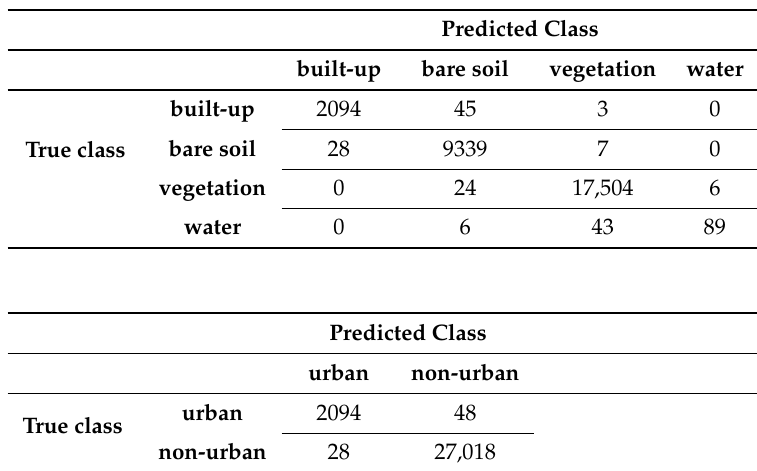
Table 3. Confusion matrices for the classification process of Landsat images in Valledupar. The top table corresponds to the initial classification process of pixels into four categories, and the bottom table corresponds to the final re-classification process into two categories.